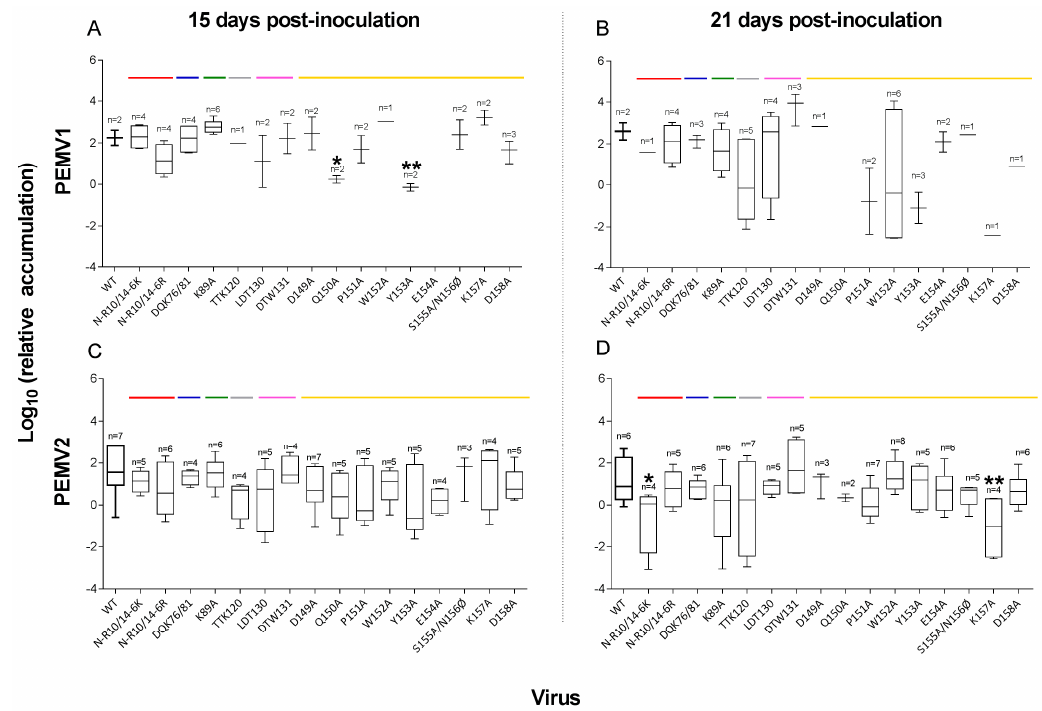
Figure 3. Accumulation of wild-type and mutant PEMV within upper leaves of inoculated pea plants. (A,B) PEMV1 and (C,D) PEMV2 RNA accumulation in upper leaves at 15 and 21 dpi of lower leaves. Viral RNA was quantified with real-time RT-PCR using actin as a reference. Colored lines correspond to the location of each mutant in the coat protein as shown in Figure 1A. The numbers of infected leaves test for each virus are shown with significant differences relative to WT indicated (* p < 0.05 and ** p < 0.01).